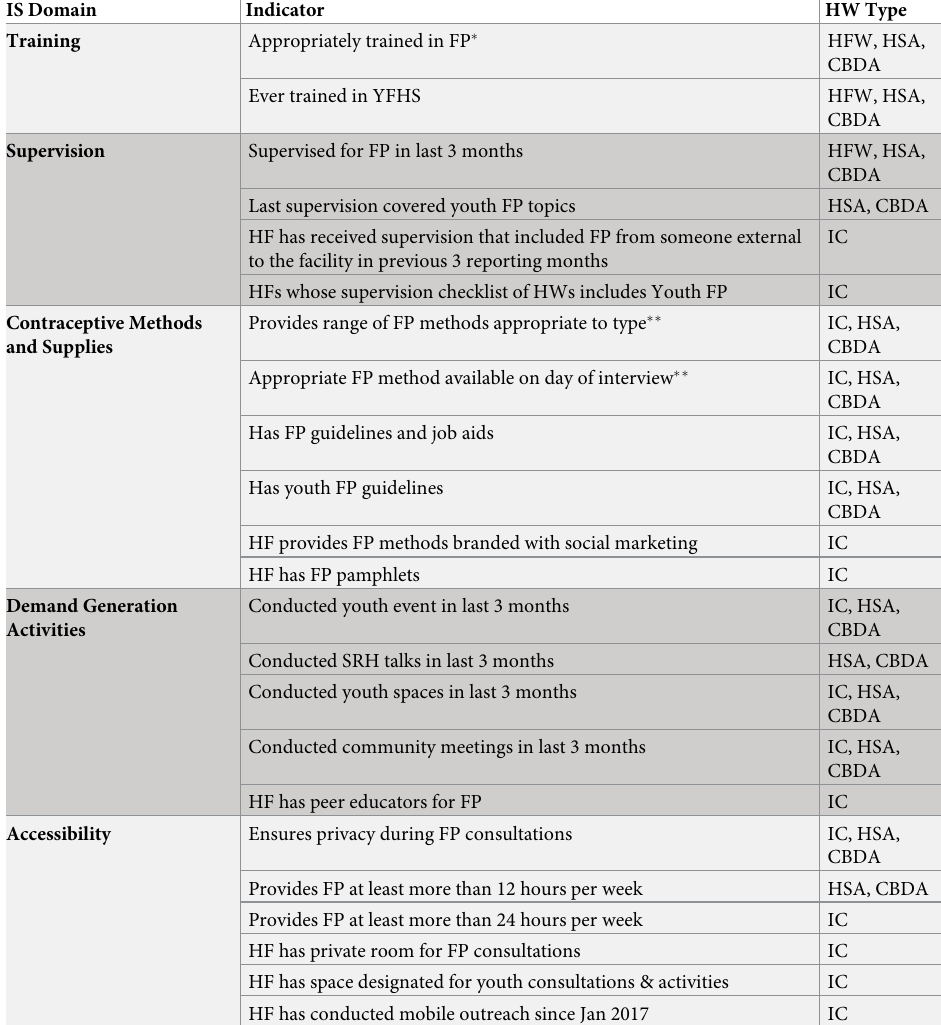
Table 1. Indicators per implementation strength domain and health worker type. IS